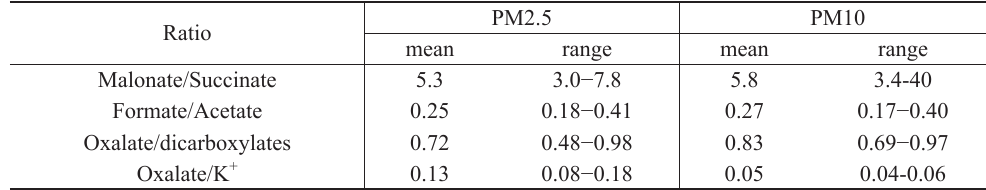
Mean ratios and associated standard deviations and range for carboxylate ions and K + in PM2.5 and PM10 aerosols at BNA in